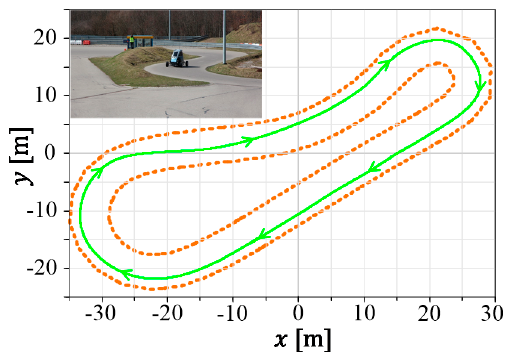
Figure 1. Path following control (PFC) experiment with ROMO (short for ROboMObil—German Aerospace Center’s (DLR’s) robotic electric vehicle) at the General German Automobile Club’s (ADAC’s) test facilities in Kempten.